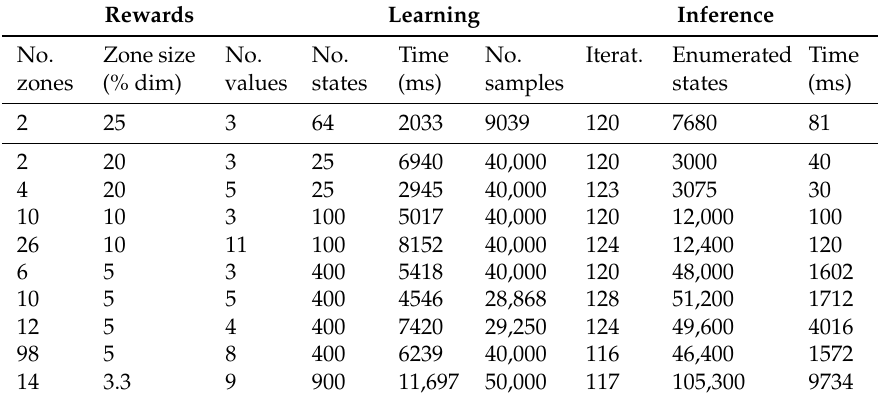
Table 3. Experimental results of learning and inferring factored MDPs.